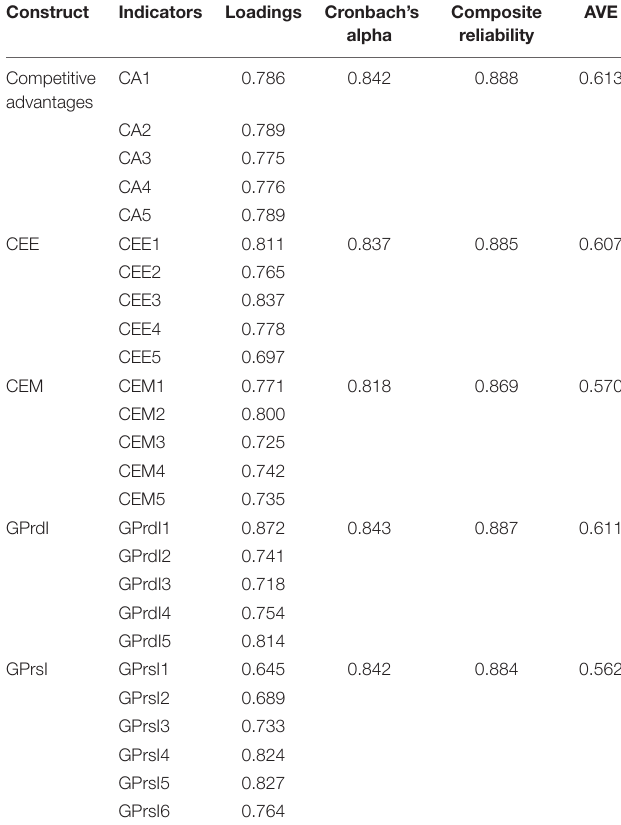
TABLE 1 | Internal consistency, convergent validity, composite reliability, and average variance extracted (AVE).